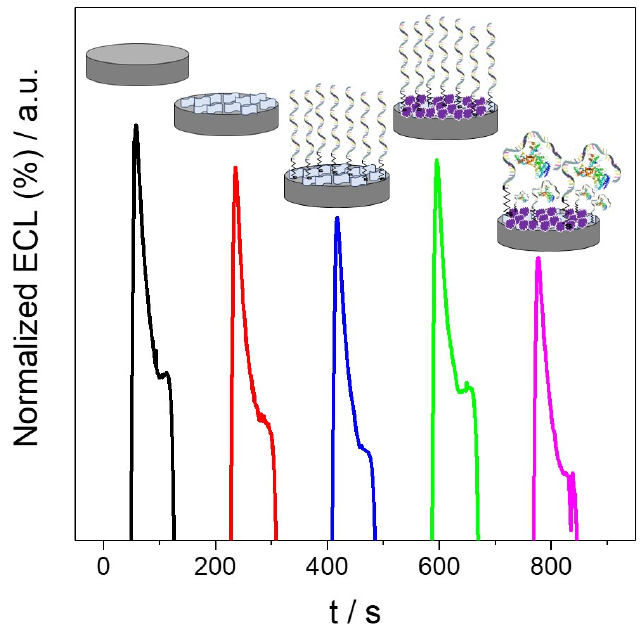
Figure 6. ECL signals of CSPE ( black curve ), CSPE/MoS 2 -NS (red curve), CSPE/MoS 2 -NS/Apt-SH (blue curve), CSPE/MoS 2 -NS/Apt-SH/BSA (green curve) and CSPE/MoS 2 -NS/Apt-SH/BSA/HER2 (purple curve; HER2 tested concentration was 13.7 pg/mL) using a solution of 7 mM [Ru(bpy) 3 ] 2+ and 8 mg/mL CDs in 0.2 M PB pH 8. Cyclic potential scan from 0.50 V to 1.40 V and 10 mV/s of scan rate.